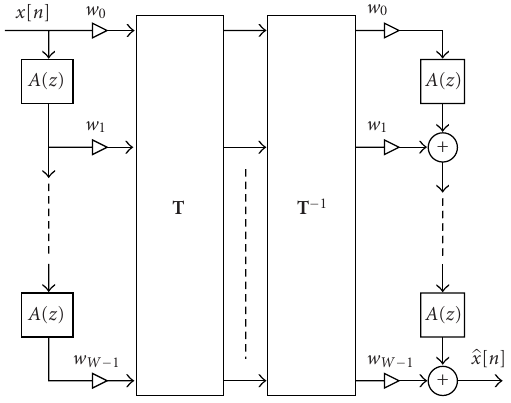
Figure 14: Nondecimated frequency-warped phase-distorted anal- ysis/synthesis